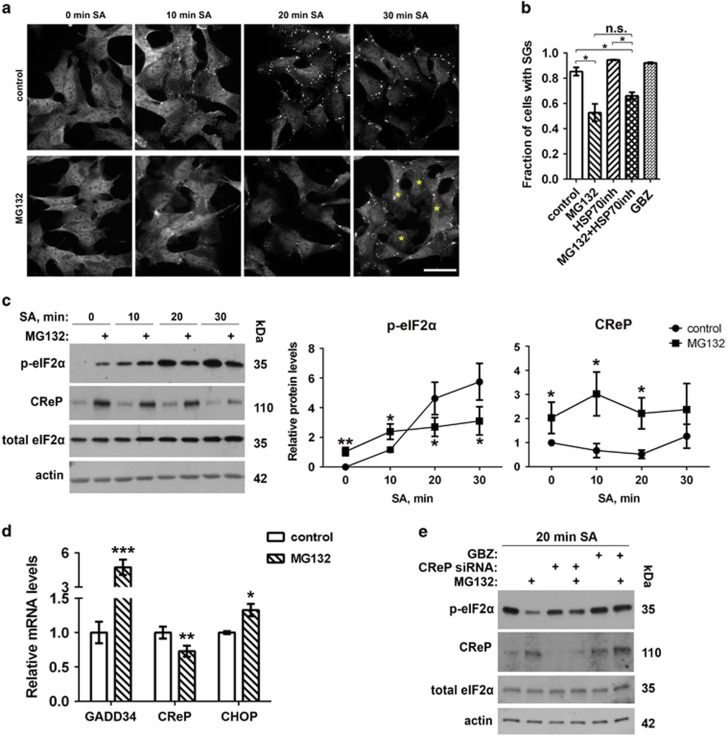
Stress preconditioning with a proteasome inhibitor MG132 upregulates eIF2α phosphatase regulatory subunits and limits the ability of SH-SY5Y cells to maintain p-eIF2α levels and SG assembly during stress. (a) SG assembly during oxidative stress is impaired after MG132 pretreatment. Cells were pretreated with MG132 (1 μM for 4 h) or left untreated, and SA was added for 10, 20 or 30 min. SGs were visualized with anti-TIAR staining. Representative images of all conditions are shown, asterisks indicate cells without SGs. Scale bar, 10 μm. (b) MG132 pretreatment leads to reduced number of cells with mature SGs after 30 min of SA exposure (n=3; *P<0.05). In contrast, pretreatment with a GADD34 phosphatase subunit inhibitor guanabenz does not affect SG assembly during stress. Cells were pretreated with 1 μM MG132 for 4 h or 5 μM guanabenz for 24 h. HSP70 inhibitor pifithrin (5 μM) was added 30 min before SA addition. (c) MG132-pretreated and control cells display different kinetics of p-eIF2α build-up during stress, and CReP protein is upregulated by MG132. Cells were treated with MG132 and subsequently stressed with SA as described in (a). Representative blots and quantification of band intensities for p-eIF2α and CReP in MG132-pretreated as compared with control cells are shown (n=5 or 6, *P<0.05, **P<0.01). For CReP and p-eIF2α band analysis, 0 and 10-min band intensity in control cells were taken as 1, respectively. (d) MG132 upregulates GADD34 mRNA. Cells were treated with 1 μM MG132 for 4 h before RNA extraction for qRT-PCR analysis. CHOP mRNA levels were measured in parallel to confirm activated stress response in MG132-treated cells (n=5, *P<0.05, **P<0.01, ***P<0.001). (e) Pharmacological inhibition of GADD34 and to a lesser extent CReP knockdown reverse the effect of MG132 pretreatment on p-eIF2α levels during stress. Cells were transfected with CReP siRNA and 72 h post-transfection treated with 1 μM MG132 for 4 h followed by SA stress; or co-treated with MG132 and 50 μM guanabenz for 4 h followed by SA stress. Cells were analyzed 20 min after SA addition. Representative western blots are shown